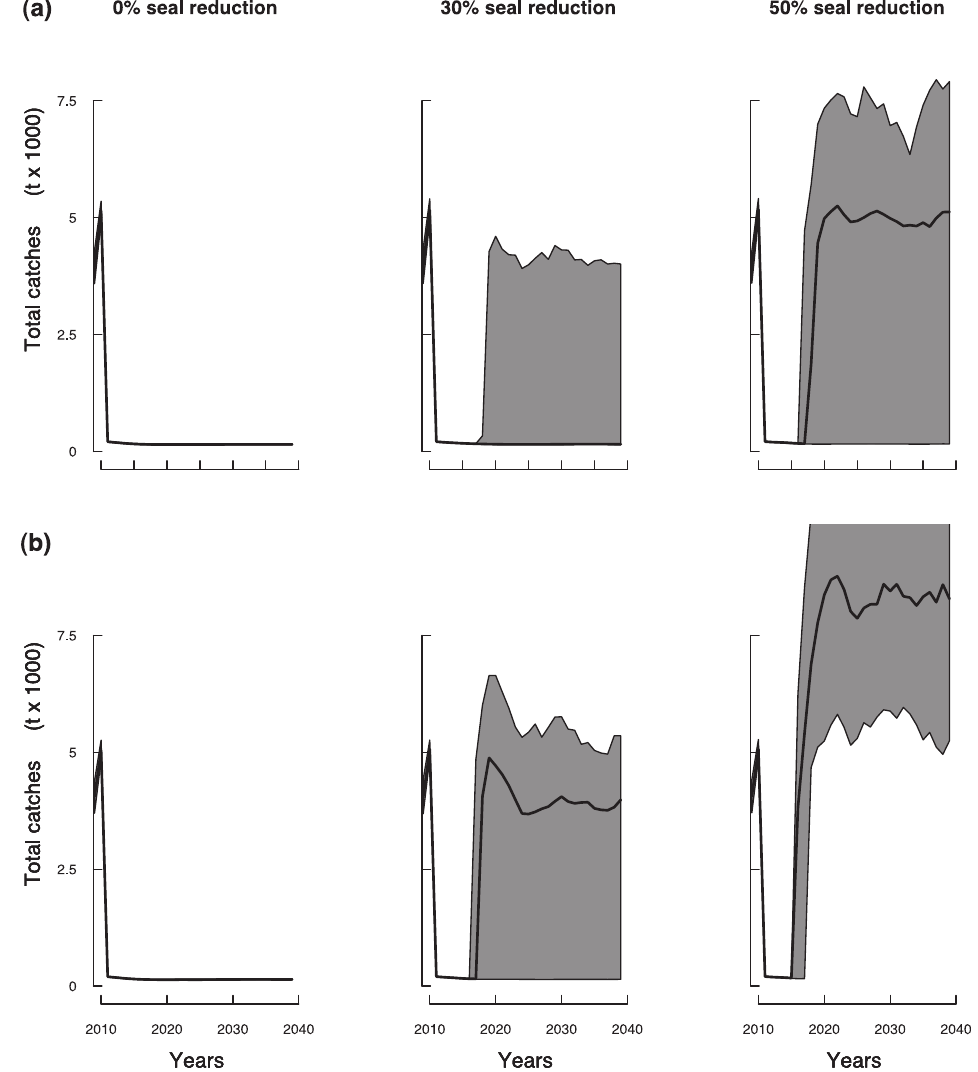
Figure 8. Cod total catches forecast in years 2010–2040 under water standard conditions. [ (a) : CIL=0.25 u C] and warming conditions [ (b) : CIL=0.75 u C], for the reduced catch fishing regime. Plain lines and grey areas indicate median values and 90%-confidence domains, respectively.